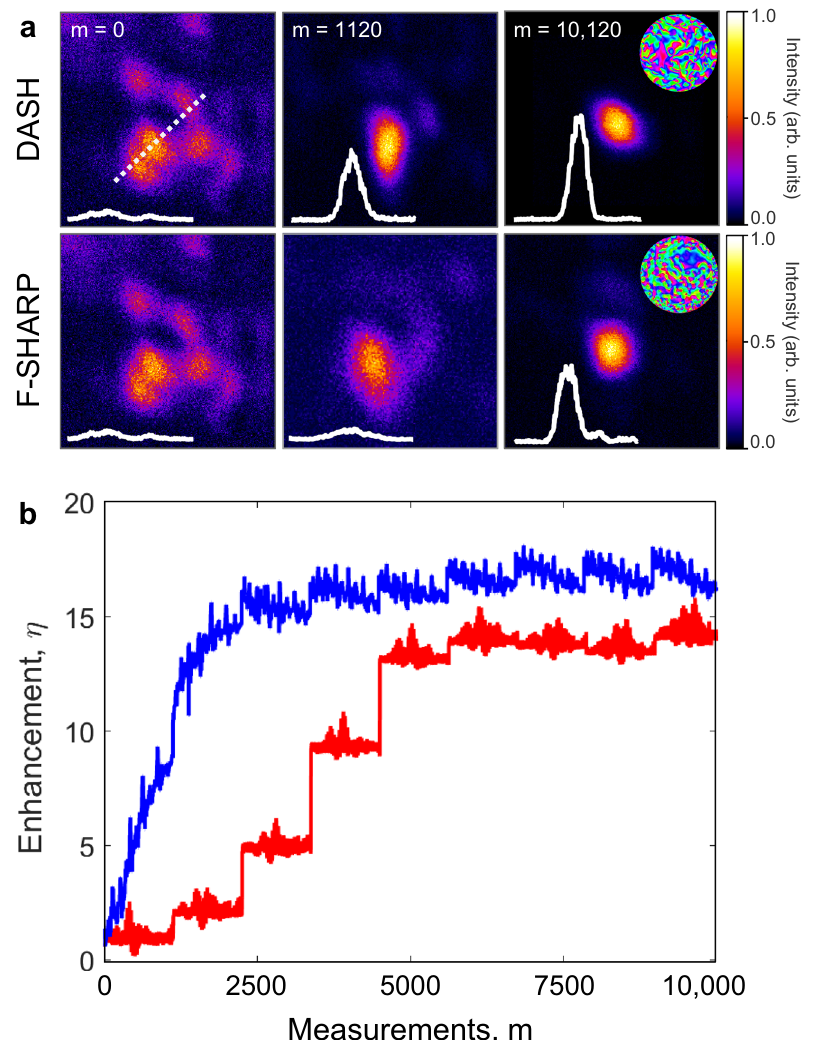
Fig. 2 Comparison of DASH and F-SHARP. a TPEF images of a quantum dot sample in DASH (top) and F-SHARP (bottom) before correction, after one iteration, and after both algorithms have converged with intensity pro fi les extending over a lateral distance of 5 μ m along the dashed line and the fi nal phase masks shown as insets along with the measurement number, m. b Signal enhancement η on a uniform dye sample after each mode measurement during DASH (blue) and F-SHARP (red)